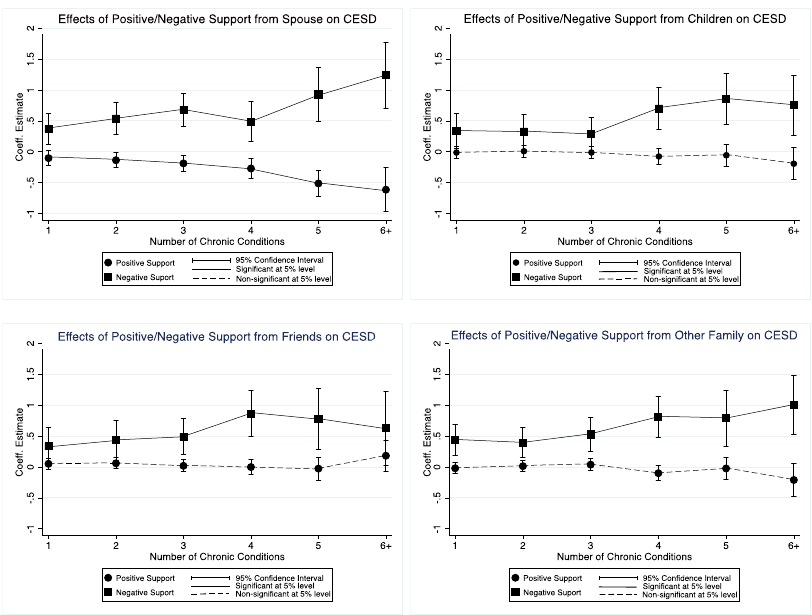
Figure 1. Effects of positive/negative supports from spouse, children, other family, and friends on CESD depression.